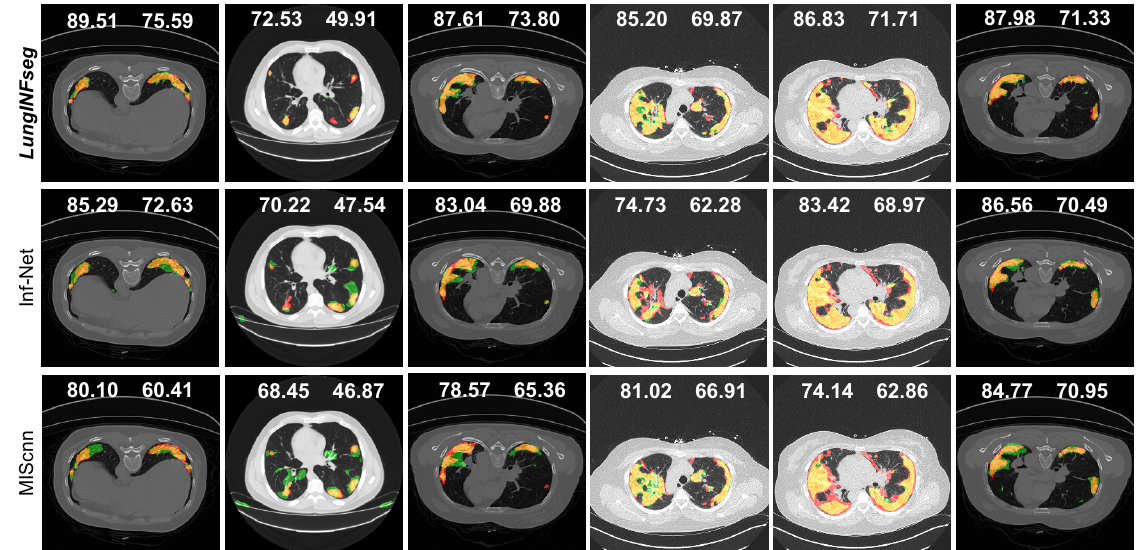
Figure 16. Qualitative comparison of the segmentation results of the LungINFseg, Inf-Net, and MIScnn. Here, left and right side numbers on each example refer to dice and IoU scores, respectively. The colors are used to represent the segmentation results as follows: TP (orange), FP (green), FN (red), and TN